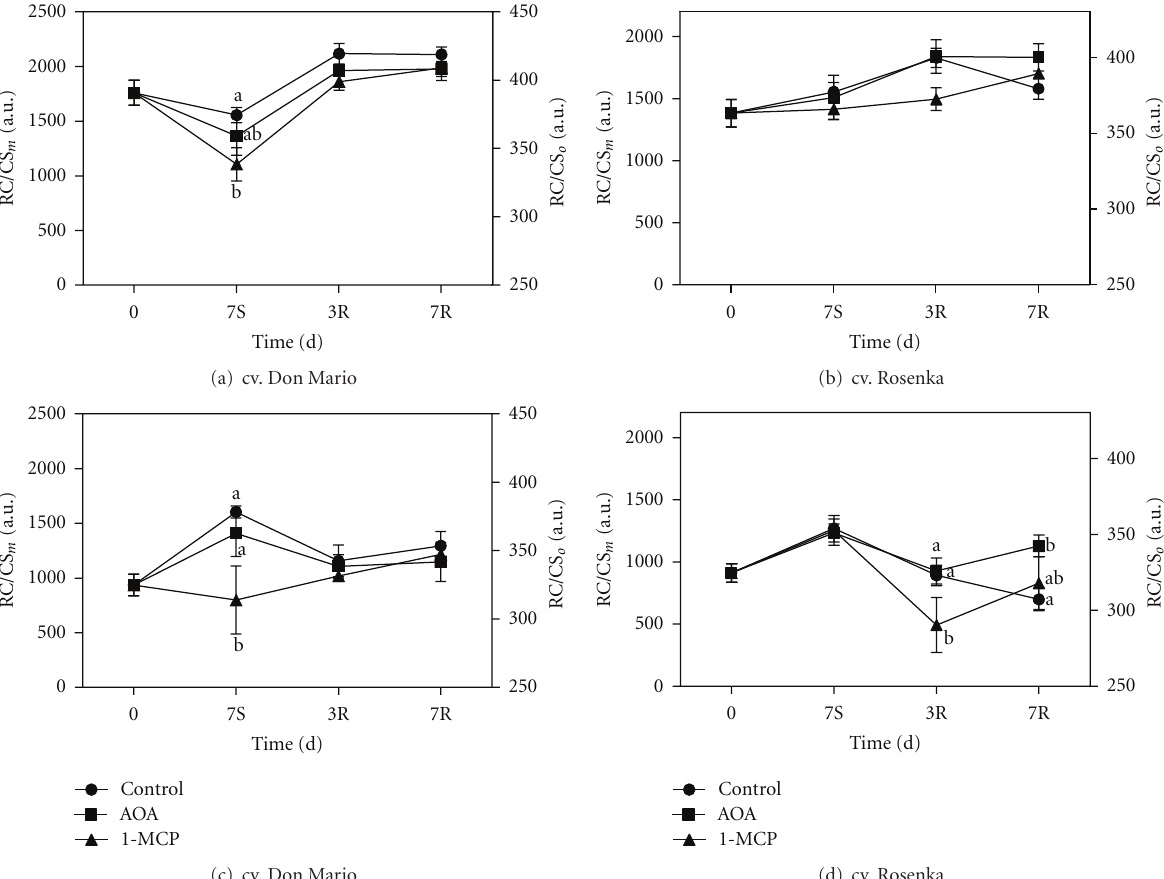
Figure 8: Density of reaction centers per CS at F m (RC/CS m ) measured from leaves of cv. Don Mario (a) and cv. Rosenka (b) and density of reaction centers per CS at F o (RC/CS o ) measured from leaves of cv. Don Mario (c) and cv. Rosenka (d) stored for 7 days (7S) at 14 ◦ C and transferred at 20 ◦ C for recovery evaluation (3R and 7R). Values are means with standard errors ( n = 10). Data were subjected to one-way ANOVA, and di ff erent letterss, when present, mean that values are statistically di ff erent, P < 0 .